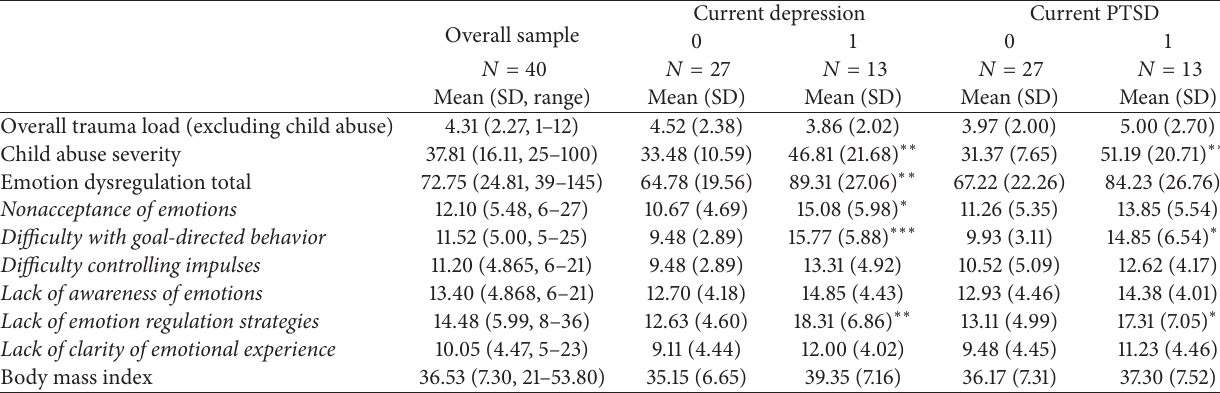
Table 1: Descriptive characteristics of variables of